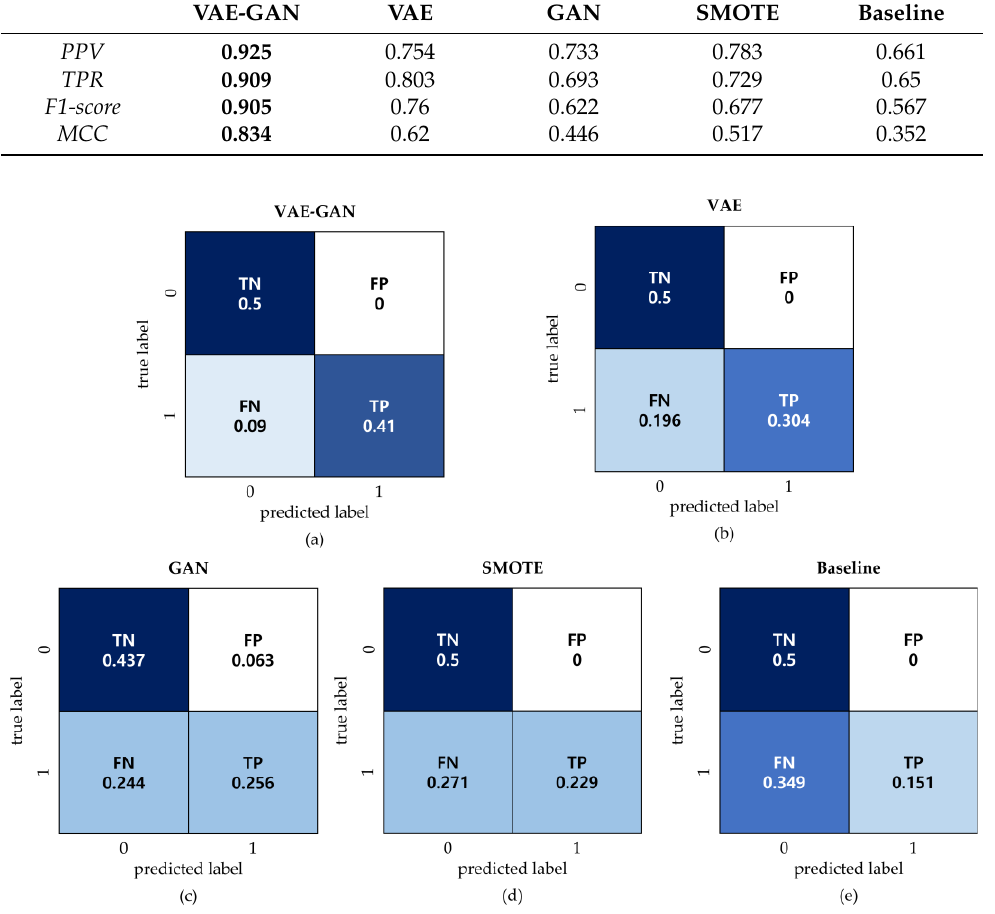
Figure 3. Confusion matrices of classification result on ( a ) VAE-GAN; ( b ) VAE; ( c ) GAN; ( d ) SMOTE; ( e ) Baseline.